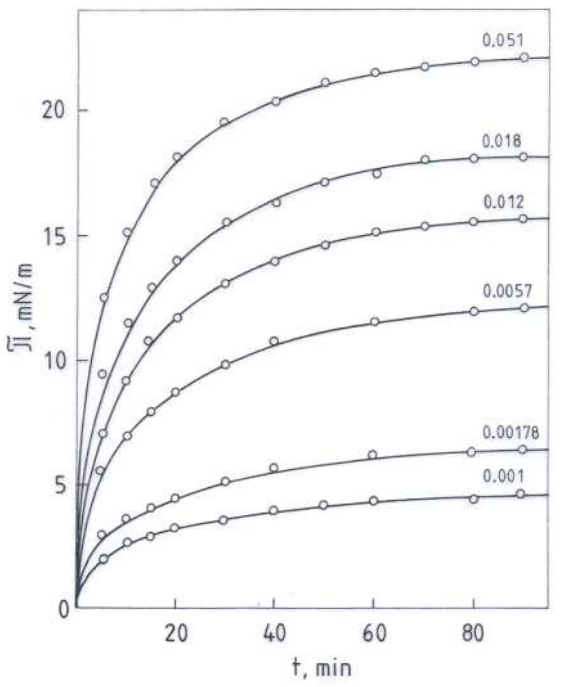
Fig. 3 Dynamic interfacial pressure (Π in mN/m) of stearic acid benzene solutions at the ben- zene/water (pH 2) interface. Figures indicate the stearic acid bulk concentration ( c 0 in mole dm − 3 ).